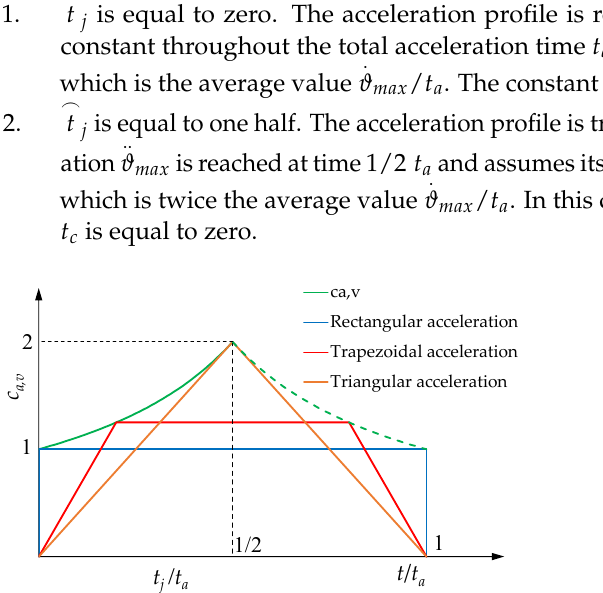
Figure 2. Symmetrical trapezoidal acceleration profile. Figure 3 shows the profile of